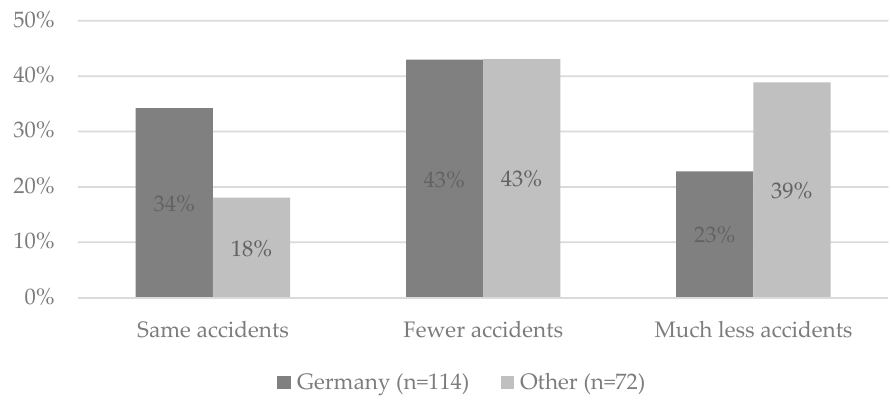
Figure 7. Acceptable levels of safety for driverless vehicles with remote operation as fallback system.